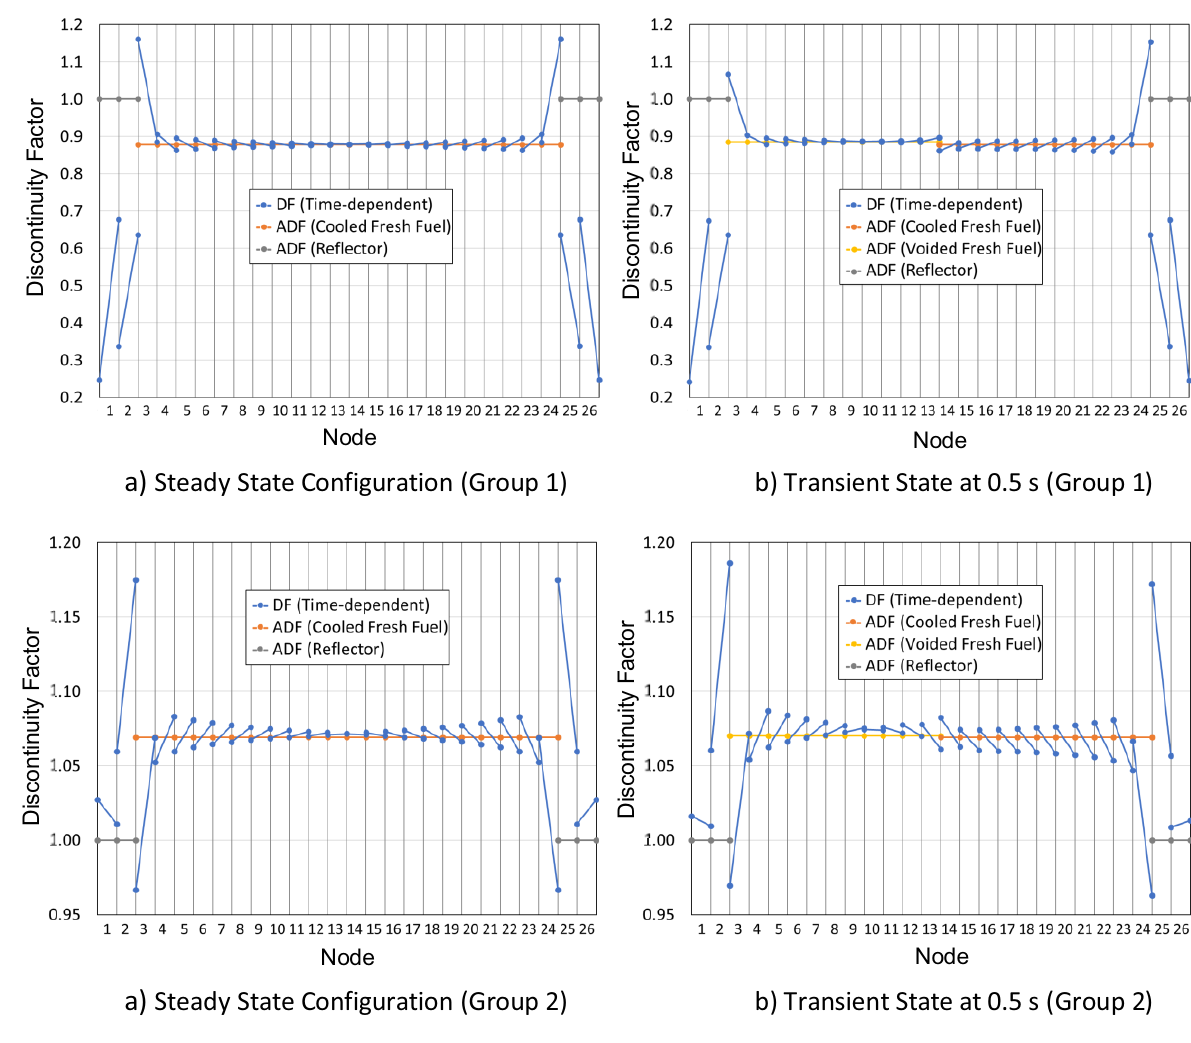
Figure 8. Time-dependent Discontinuity Factors and Assembly Discontinuity